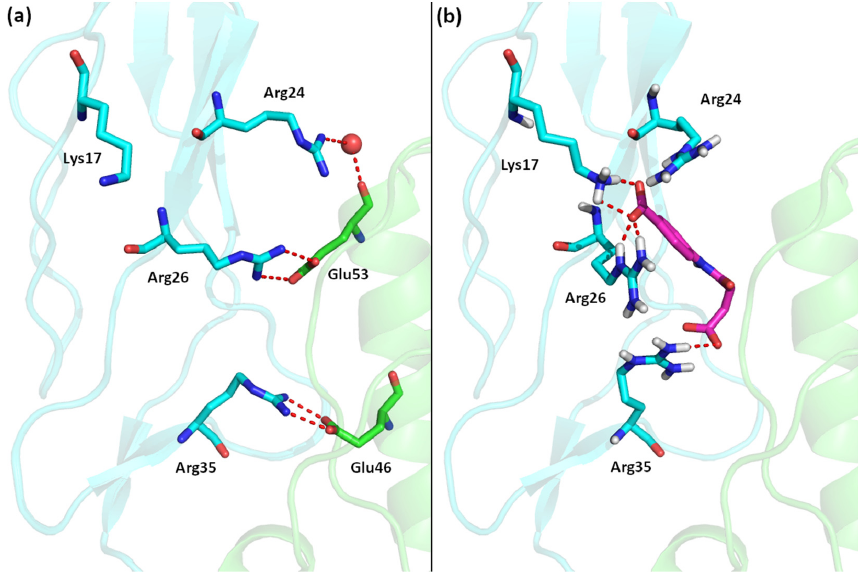
Figure 1. ( a ) The interface of the IL–15/IL–15R α complex. ( b ) Best computational pose of 7a docked to IL–15R α (IL–15 in green, IL–15R α in blue).